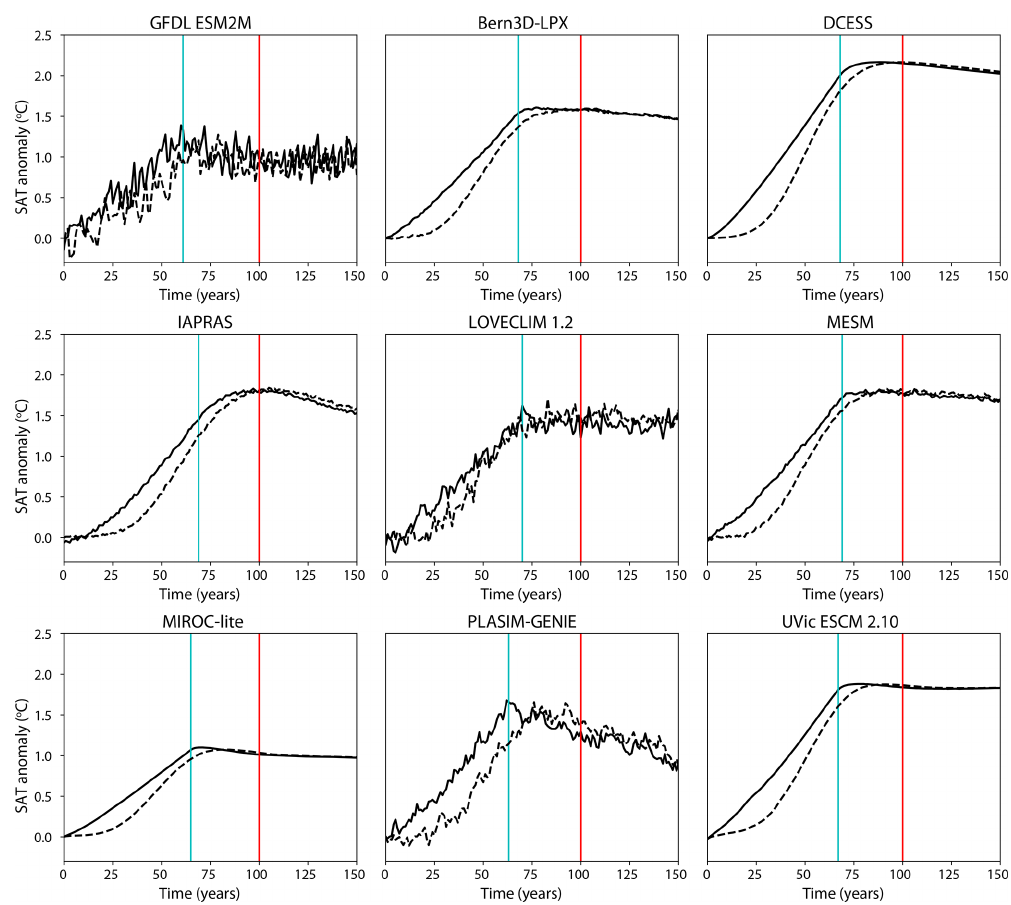
Figure 4. Temperature evolution of A1 (1% to 1000PgC) and B1 (bell-shaped emissions of 1000PgC over 100 years) experiments relative to pre-industrial temperature. Solid lines are the A1 experiment and dashed lines are the B1 experiment. The vertical blue line shows when emissions cease in the A1 experiment, and the vertical red line shows where emissions cease in the B1 experiment.